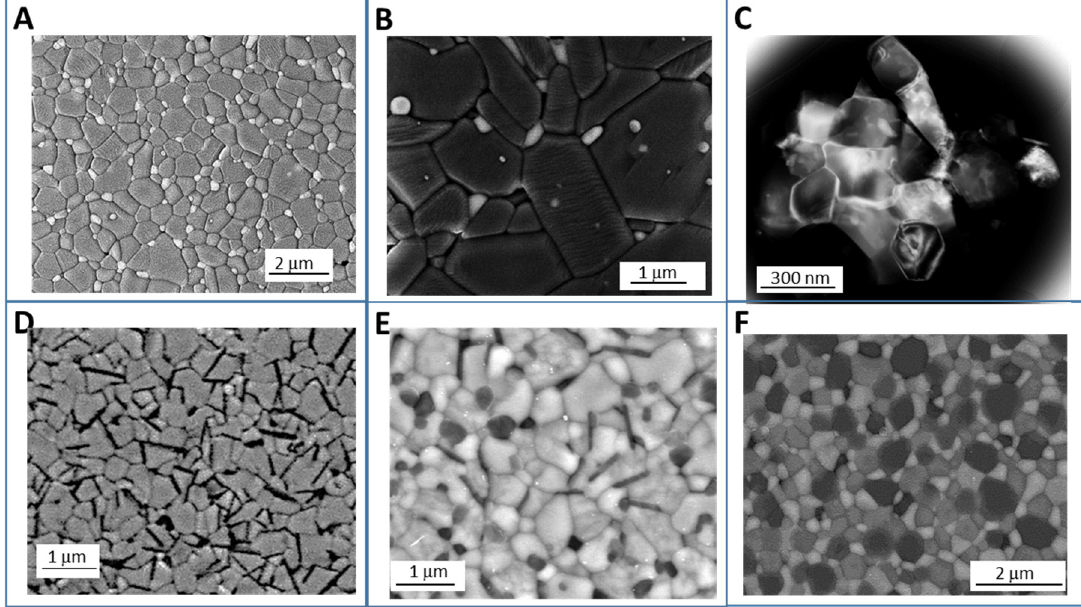
Figure 3. Example of different kinds of developed ceramic composite/nanocomposite structures. ( a ) Micro/nano Al 2 O 3 /Y 3 Al 5 O 12 (YAG) composite, with YAG predominantly located at Al 2 O 3 grain boundary [18]; ( b ) Al 2 O 3 /ZrO 2 composites, in which ZrO 2 grains occupy both inter and intragranular positions [18]; ( c ) Ultra-fine Al 2 O 3 /50 vol. %Y 3 Al 5 O 12 (YAG) composite, with interpenetrating microstructure; ( d ) Y 2 O 3 -stabilized ZrO 2 matrix containing elongated hexa-aluminate SrAl 12 O 19 grains; ( e ) Triphasic composite, consisting on a ceria-zirconia matrix and containing both rounded α -Al 2 O grains and elongated hexa-aluminate SrAl 12 O 19 grains [14]; ( f ) Ultra-fine Ultra-fine Al 2 O 3 /33 vol. %Y 3 Al 5 O 12 /33 vol. %ZrO 2 composite